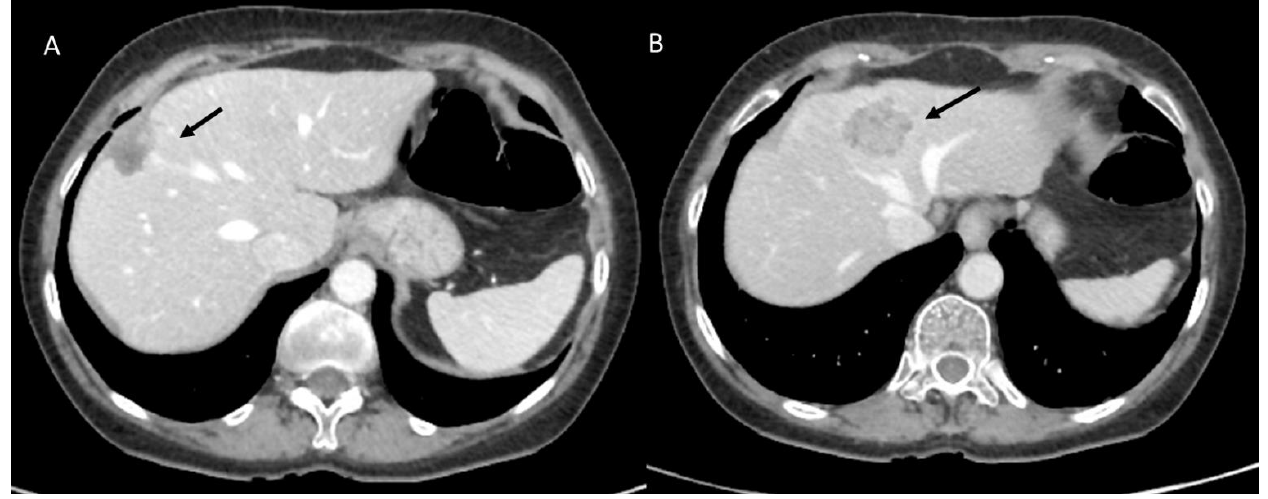
Figure 8. CT assessment in colorectal metastasis-resected patient ( A ). In ( B ), arrow shows a new